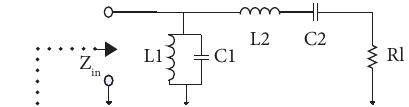
Figure 25: Te circuit with one branch of RCN and load.